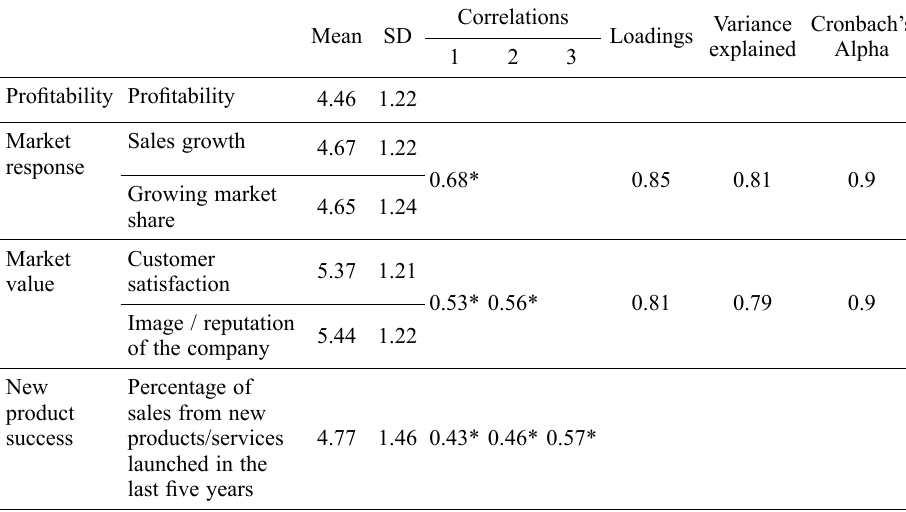
Table 4. Measurement scale: performance